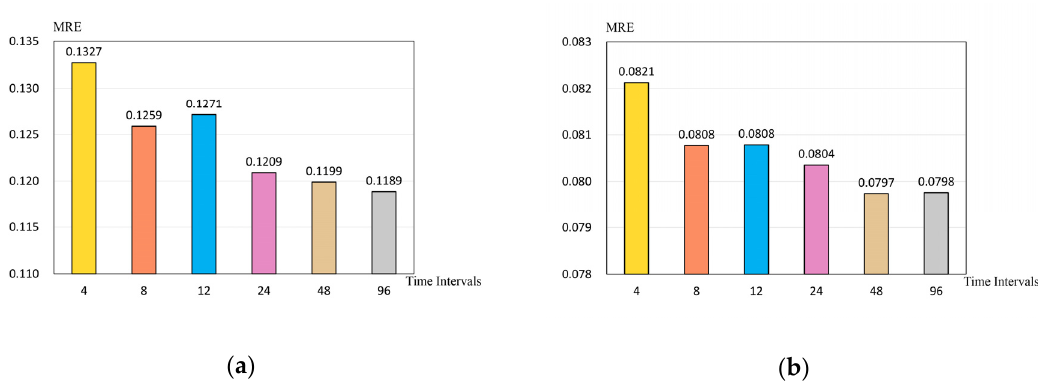
Figure 11. Mean relative errors under the DLC and DQ-DTA models with different levels of time interval perturbation. ( a ) DLC model. ( b ) DQ-DTA model.